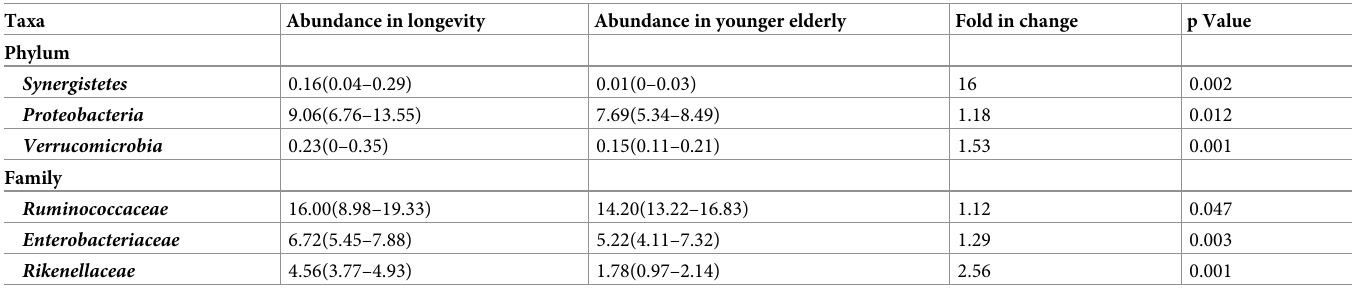
Table 2. The different relative abundance between the 65–70 and 90+ year age groups at phylum and family levels. Abundance in